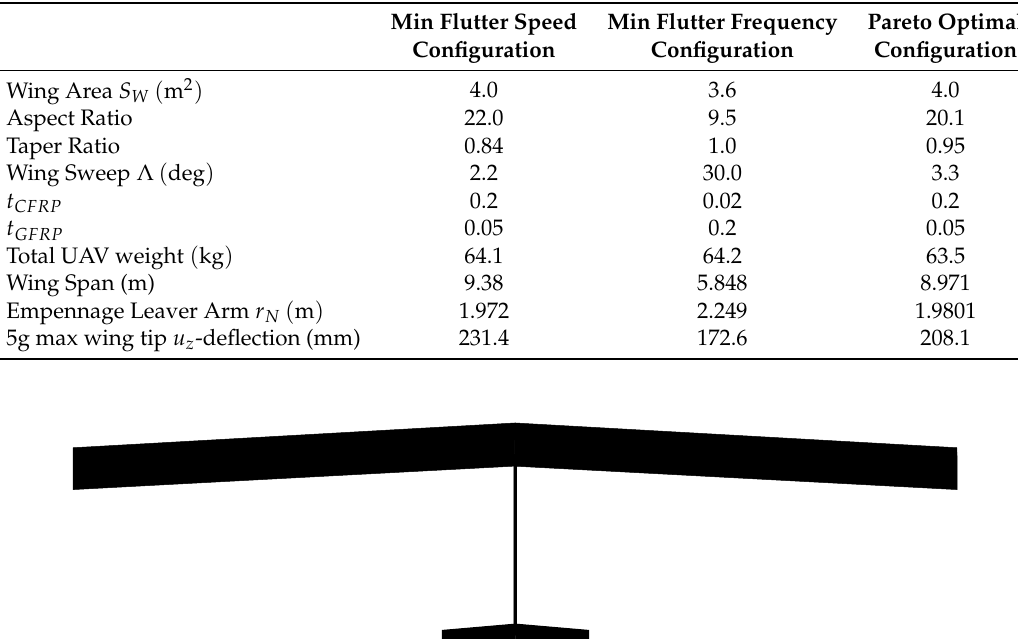
Table 5. Design summary of the three concluding UAV configurations.